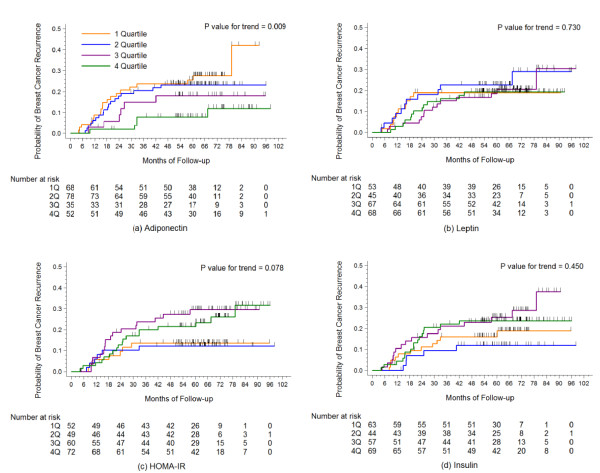
Kaplan-Meier cumulative recurrence curves for breast cancer patients in the estrogen receptor/progesterone receptor negative group. The P-values for trend were calculated using the log-rank test for trend across the quartiles of adiponectin, leptin, HOMA-IR, and insulin. The hatch marks on the curves indicate times when patients were censored.